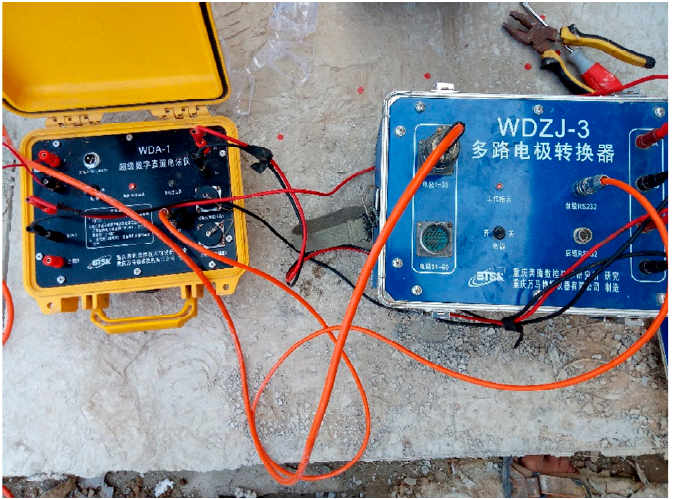
Figure 5. High-density resistivity method.